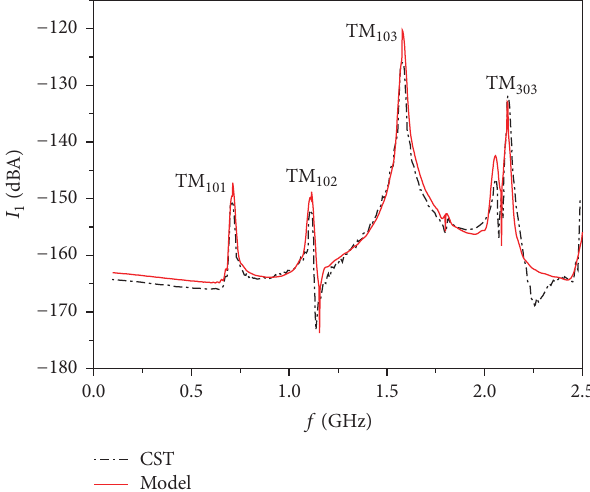
Figure 12: Component of electric field 𝐸 out 𝑦 at ( 150, 60, 450 ) mm from the analytical model and the CST.